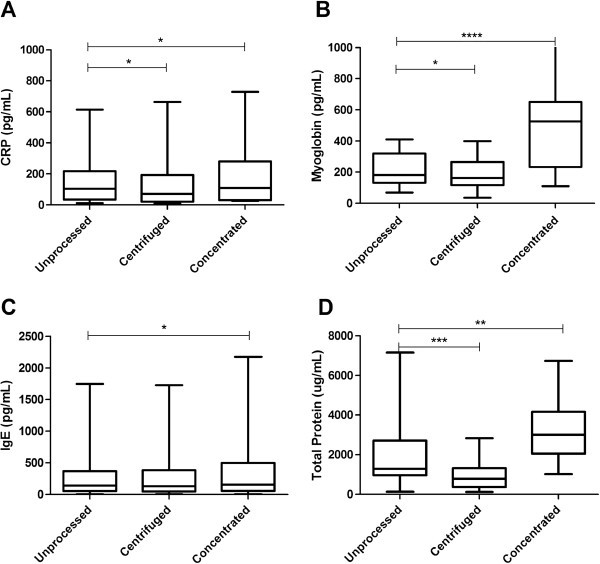
Concentration of (A) CRP, (B) Myoglobin, (C) IgE and (D) Total Protein in the unprocessed drool, centrifuged drool and molecular weight cut-off concentrate samples. Minimum and maximum data values are indicated by bottom- and top-most points of box plot. Lower quartile, median and upper quartile values are indicated by first, second and third horizontal lines of the box in the box plot. Significance is shown as *p <0.05, **p <0.01, ***p <0.001, ****p <0.0001.